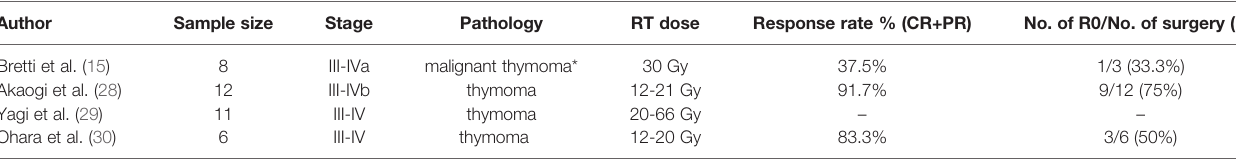
TABLE 2 | Induction radiotherapy for locally advanced